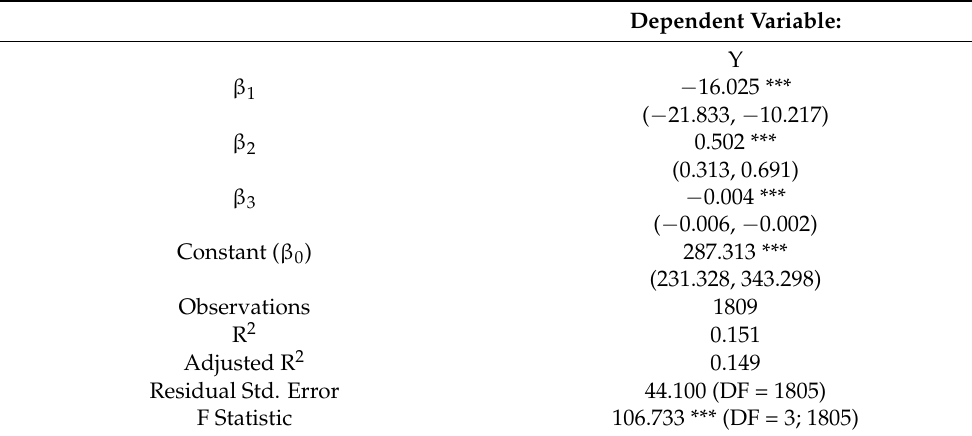
Table 4. Model coefficients (and confidence intervals).